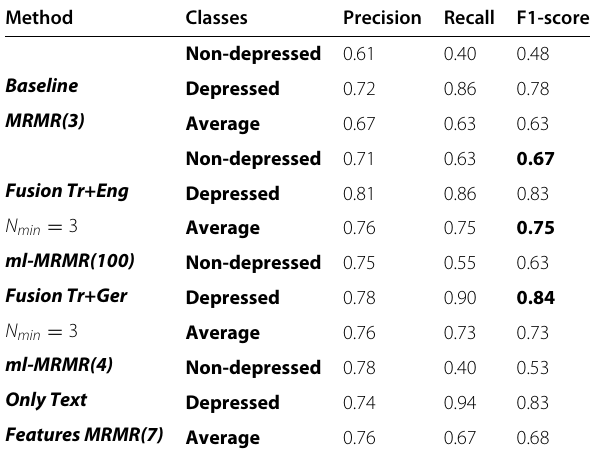
Table 11 Classification results after fusing acoustic- and text-based classifier outputs. Turkish database was used. The results are statistically insignificant except N min = 3 with German